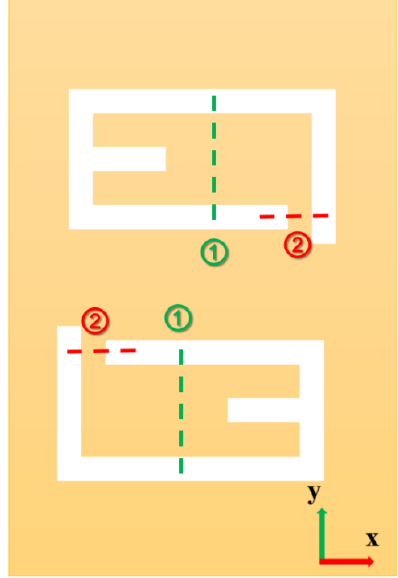
Figure 2. The unfolding 2D pattern figure of the designed 3D unit cell, which is the initial state derived reversely from the forming process of 3D meta-atom by FIB-SID bending. The FIB-SID bending areas for transformation processes are marked as green lines and red lines, respectively.